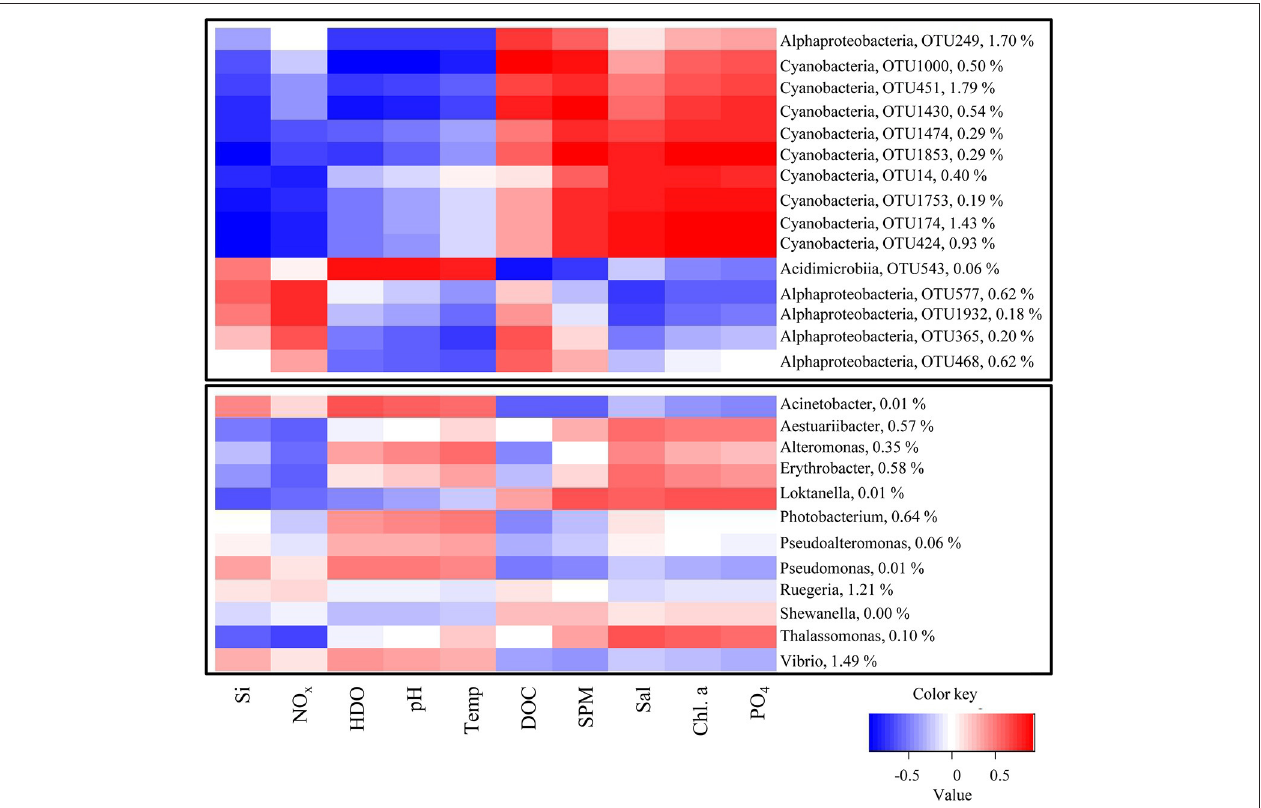
FIGURE 9 | Heatmap showing correlation of bacterial OTUs to environmental parameters. Top panel shows most abundant bacteria, lower panel shows PSIB. Environmental parameters measured were silicate (Si), nitrite/nitrate (NO x ), dissolved oxygen (HDO), pH, temperature, dissolved organic carbon (DOC), suspended particulate matter (SPM), salinity (Sal), chlorophyll a (Chl a), and phosphate (PO 4 ). Relative abundance within all samples of the respective OTUs is given with the OTU